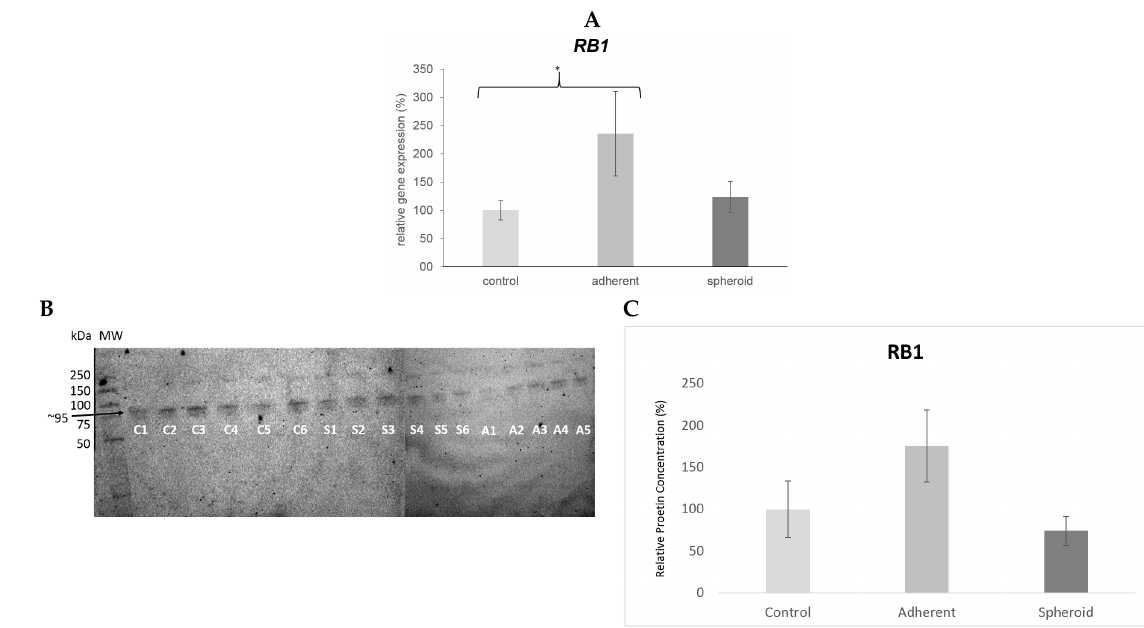
Figure 8. ( A ) PTEN gene expression was significantly upregulated (2.3×, * p < 0.05) in the adherent cells under simulated microgravity but not in the spheroids (1.4×, n.s.). ( B ) Western blot bands showing PTEN protein production (molecular weight 47 kD). Each lane 1–6 shows protein from one independent experiment (C: 1-g control, S: spheroids A: adherent cells under simulated microgravity). The bar graph below shows the average density of the blots from the respective experimental group (controls, adherent cells under simulated microgravity, spheroids). PTEN protein production was suppressed below detection level in the adherent cells under simulated microgravity and showed no significant difference compared to the 1-g-control in the spheroids. ( C ) Mean intensity of the bands in the respective group, intensity of controls defined as 100%.